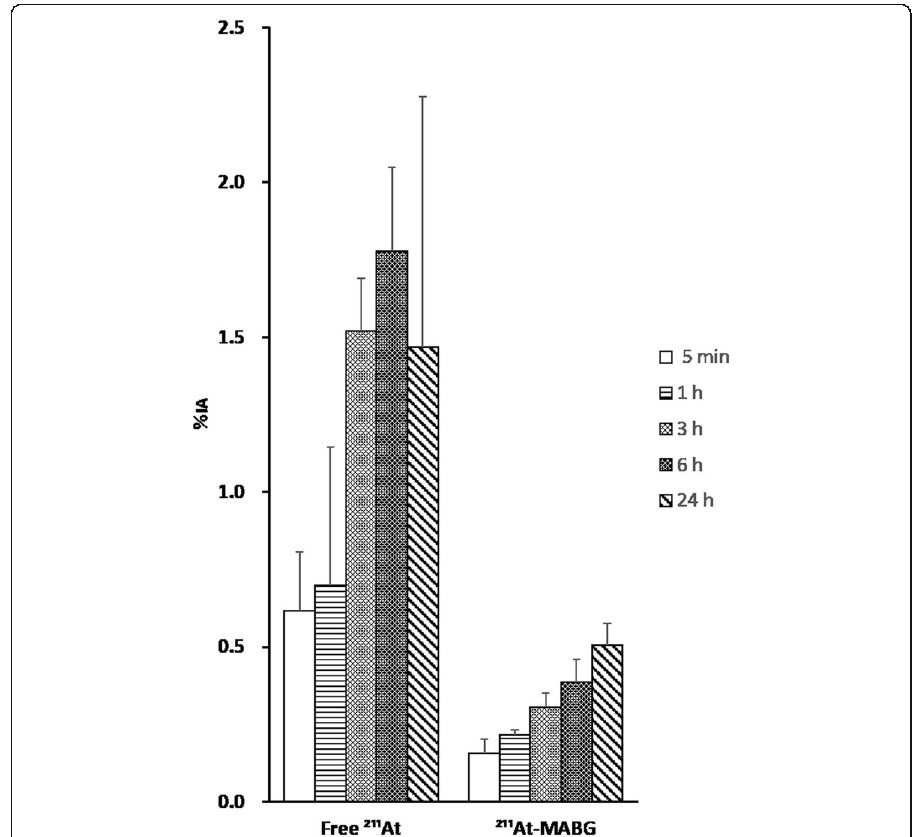
Fig. 3 Thyroid gland biodistribution data of free 211 At and 211 At-MABG. Results are shown as %IA